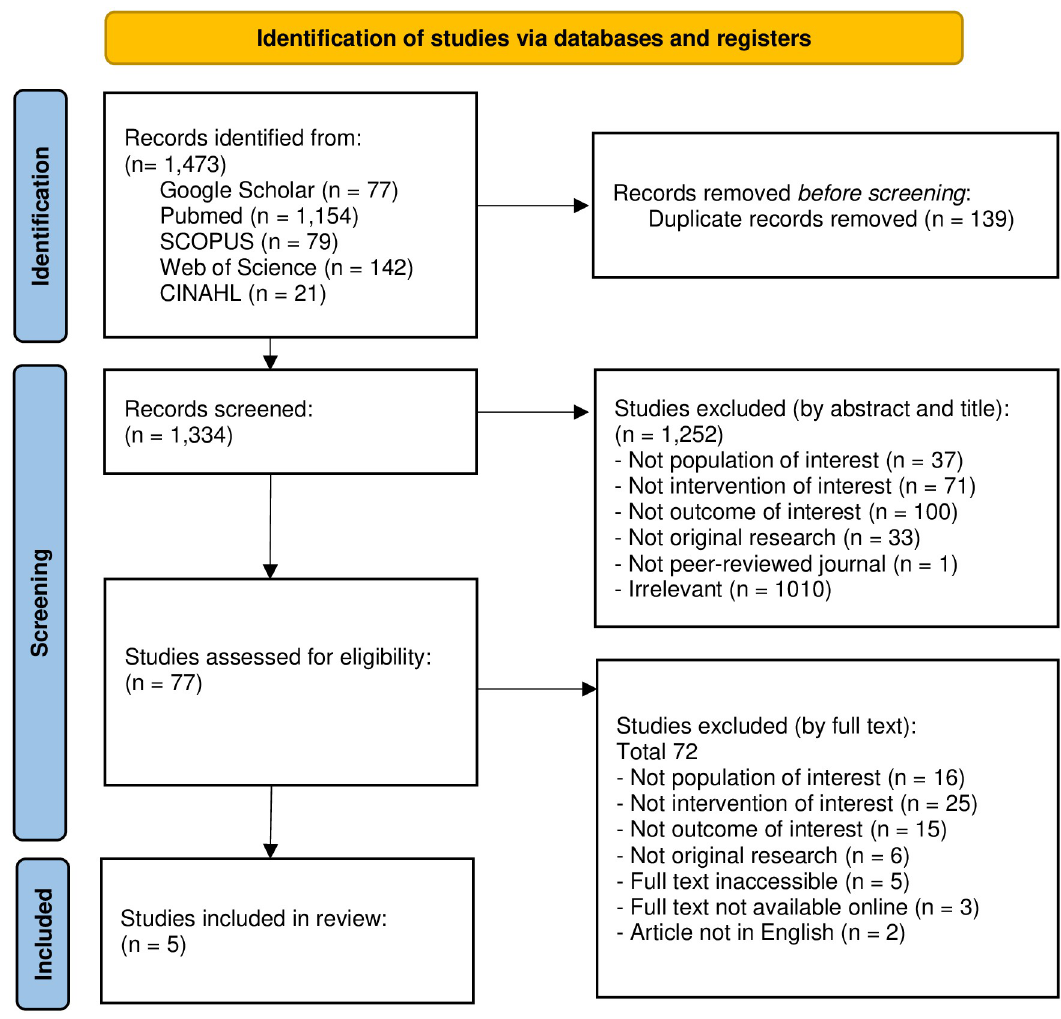
Fig 1. PRISMA flowchart of the articles search